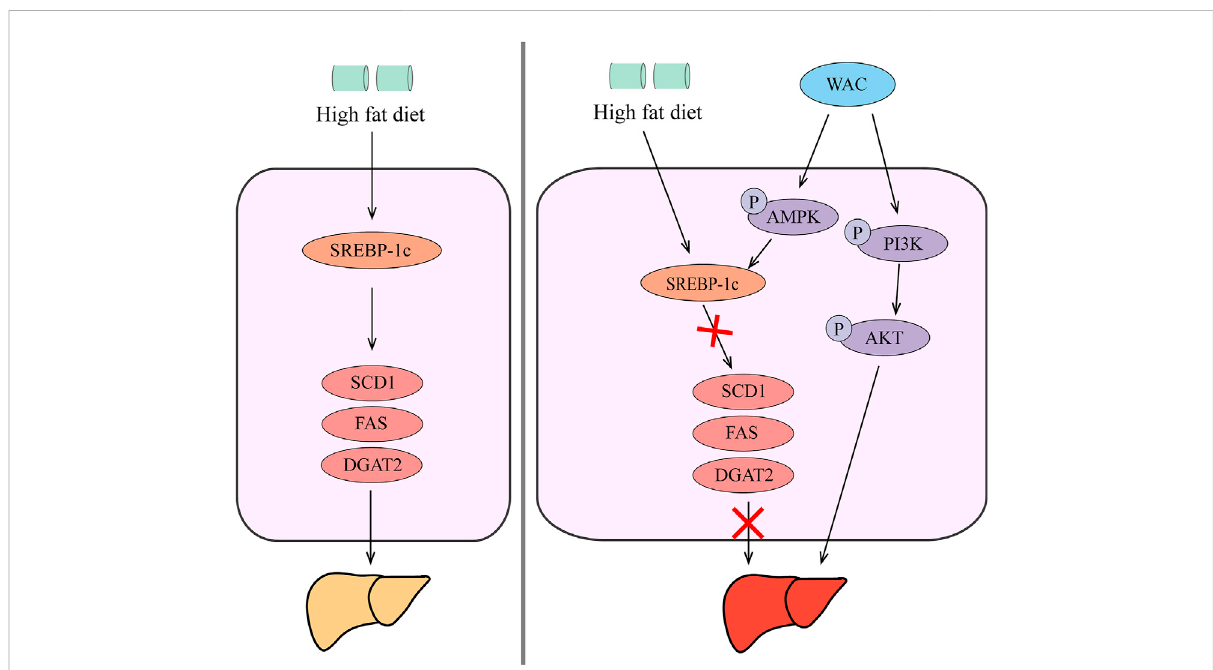
FIGURE 8 SchematicdiagramofthemechanismbywhichWACimprovesNAFLD.WACactivatesPI3K/AKTpathway,activatesAMPKtopromoteSREBP-1c expression, thereby reducing hepatic TG synthesis and lipid